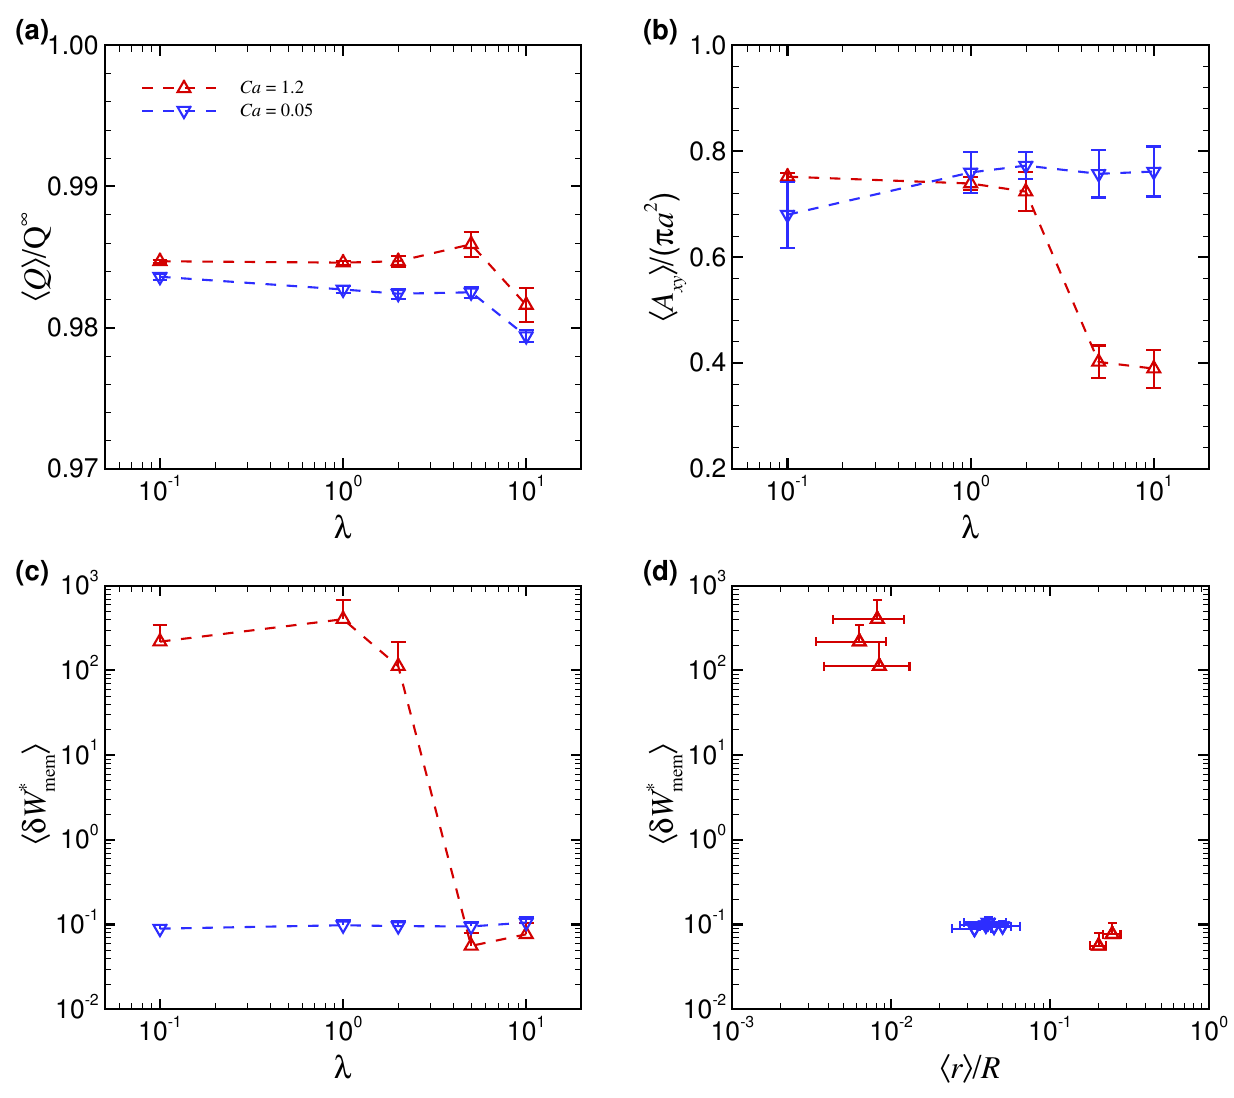
/ Q ∞ , ( b ) projected area of the RBC Q (cid:104) (cid:105) δ W ∗ mem as a function of λ for different Ca (0.05 and 1.2). ( d ) Replotted data (cid:104) (cid:105) / R for different λ . The results were obtained with an initial r (cid:104) (cid:105)